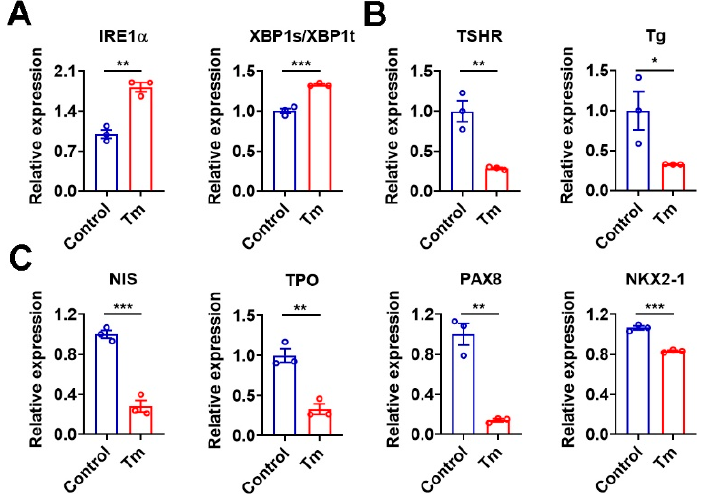
Figure 6. Activation of XBP-1 mimics the iodide excess effect on genes involved in TH synthesis in murine thyroid organoids. ( A ) Relative mRNA levels of IRE1 α (left panel) and ratio of XBP1s to XBP1t (right panel) in murine thyroid organoids treated with DMSO (as control) or Tm for 24 h ( n = 3). ( B , C ) Relative mRNA levels of TSHR, Tg ( B ), NIS, TPO, PAX8, and NKX2-1 ( C ) in thyroid organoids treated with DMSO (as control) or Tm for 24 h ( n = 3). Tm, tunicamycin. Data are presented as mean ± SEM. Statistical significance was determined by Student’s t -test; * p < 0.05, ** p < 0.01, and *** p < 0.001.